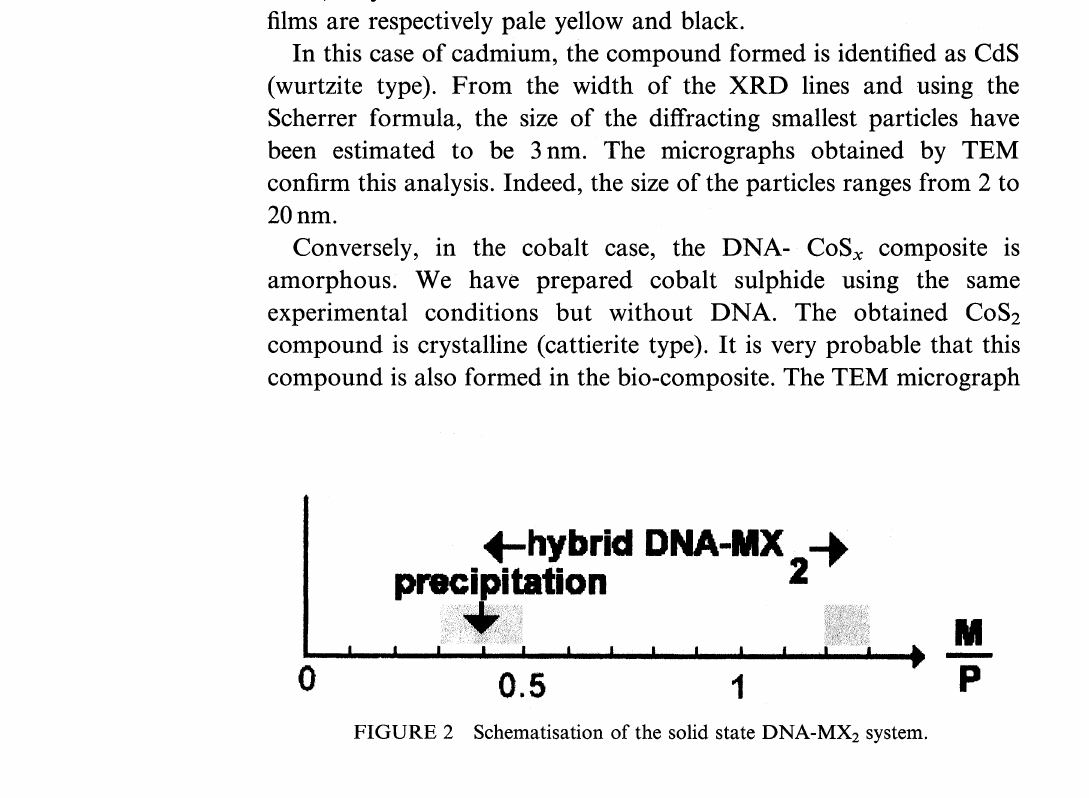
FIGURE 2 Schematisation of the solid state DNA-MX2